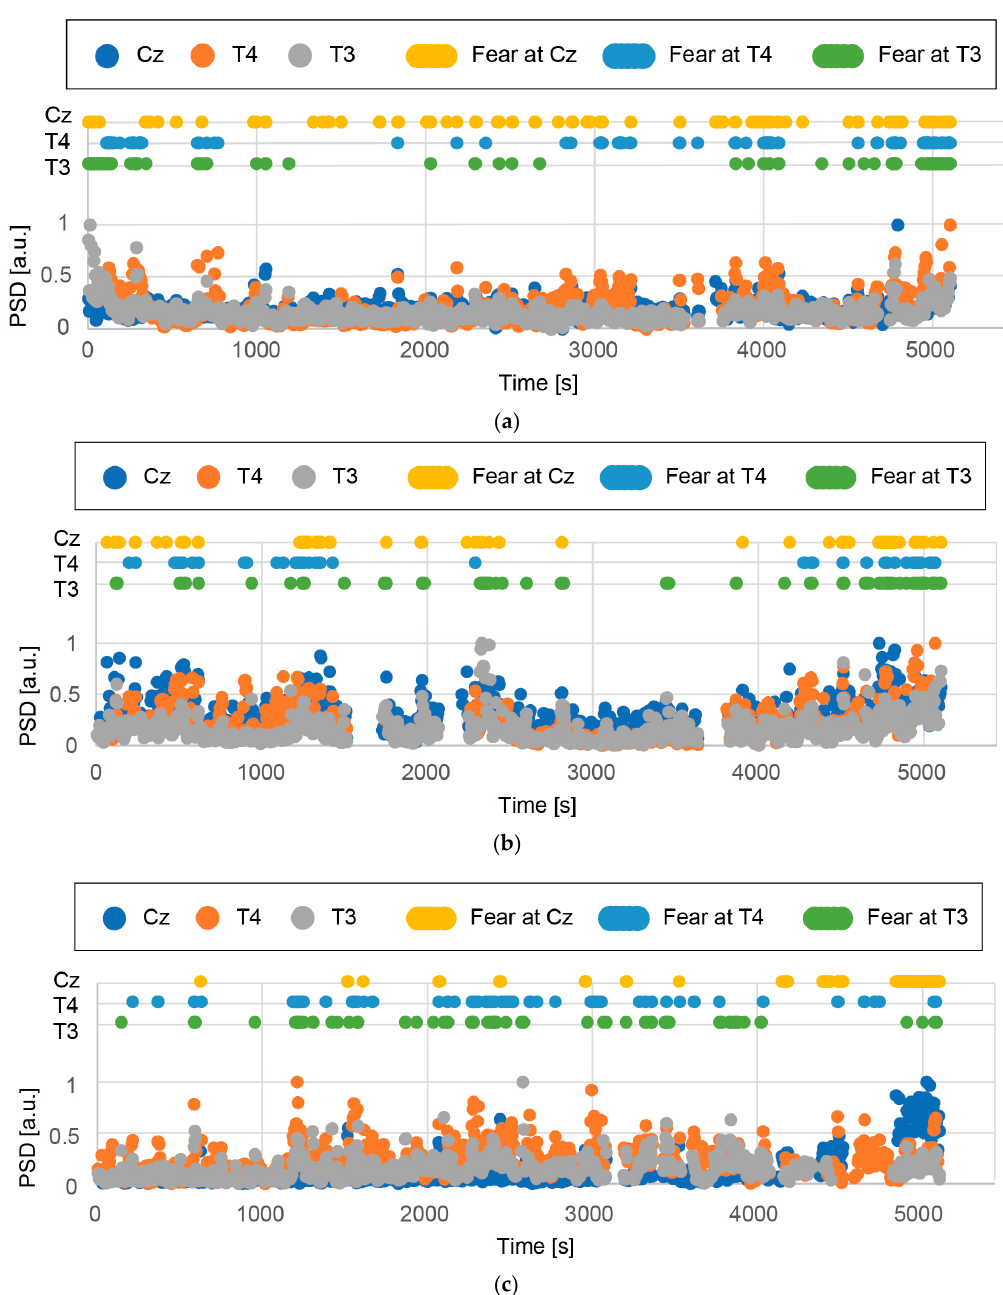
Figure 12. Normalized PSD for high- β / α for participants ( a ) A, ( b ) B, and ( c ) C. In the figures, the time when the PSD for high- β / α is in the top 10% is also shown with respect to the measurement sites. The analysis was conducted for periods of 5 s.